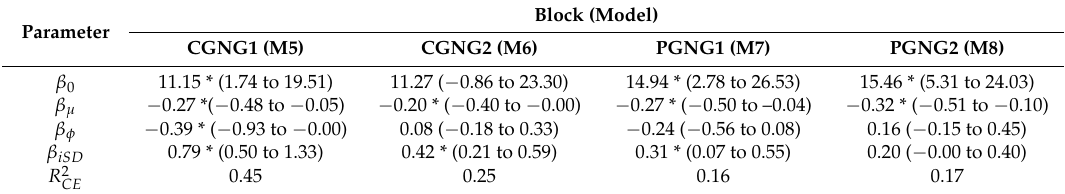
Table 3. Posterior means (and 95% CI) of intercepts and regression weights of CE i , on µ i , iSD i , and φ i , estimated for models 5 to 8. Estimates are shown in within-level standardized